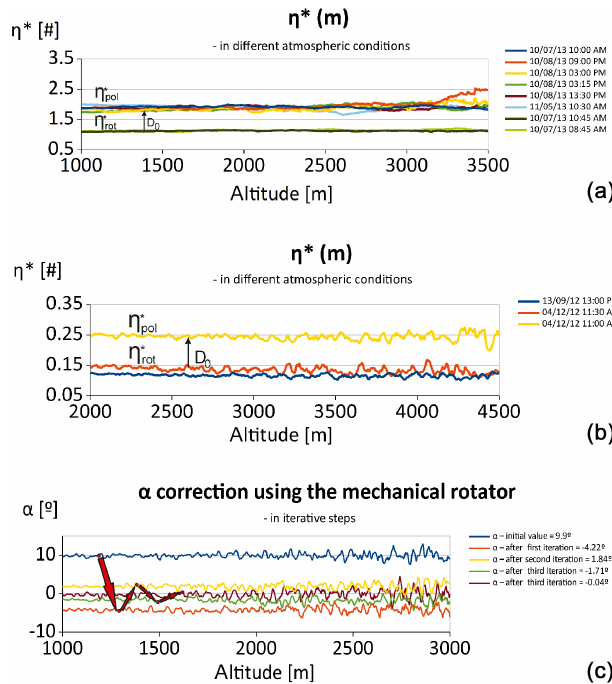
Figure 7. Calibration values using two experimental techniques: polarizer rotation calibrator ( η ∗ ) and mechanical rotation cal- before ibrator ( η ∗ ) (a) for the Bucharest lidar; (b) for the Granada lidar. after (c) Assessment and correction of α ( Y ) parameter for the Bucharest lidar using the iterative procedure, mechanical rotator in front of the